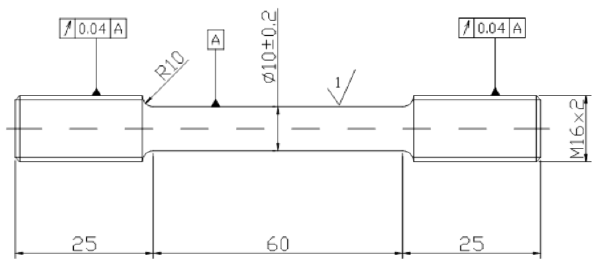
Figure 8. Manufacturing sketches of the specimens used in tests at low deformation speed. Dimensions in mm.